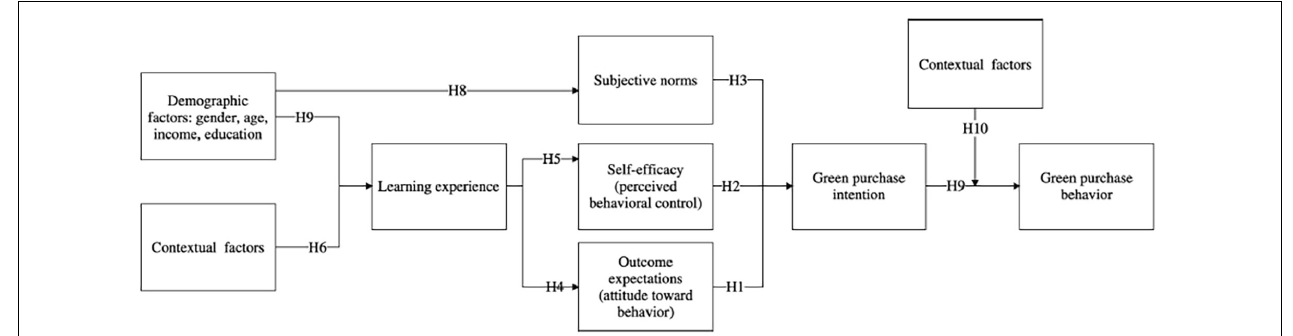
FIGURE 1 | Conceptual